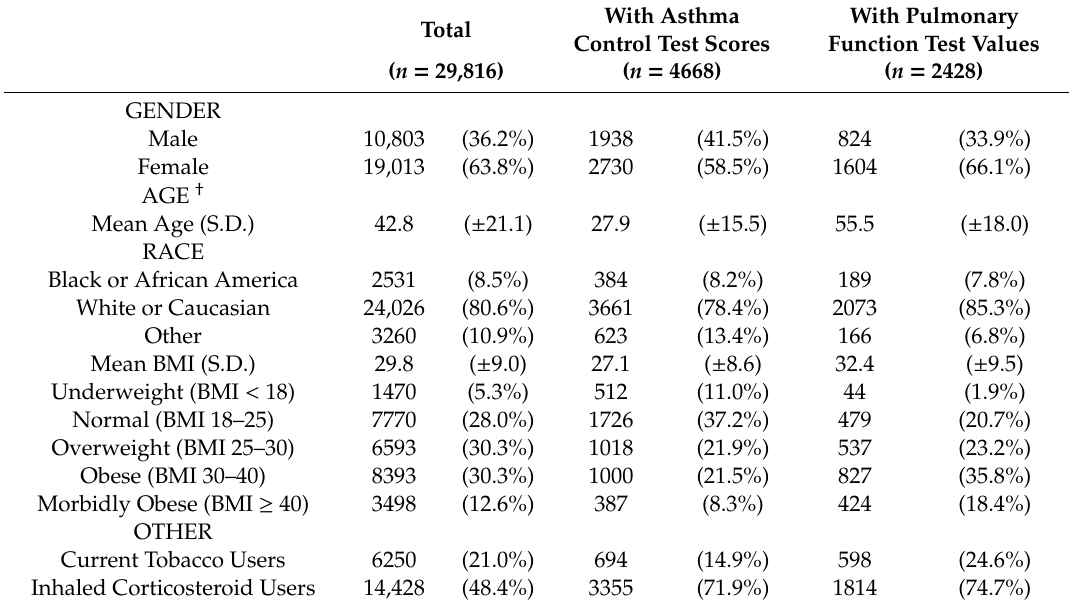
Table 1. Demographic data of the study cohorts.